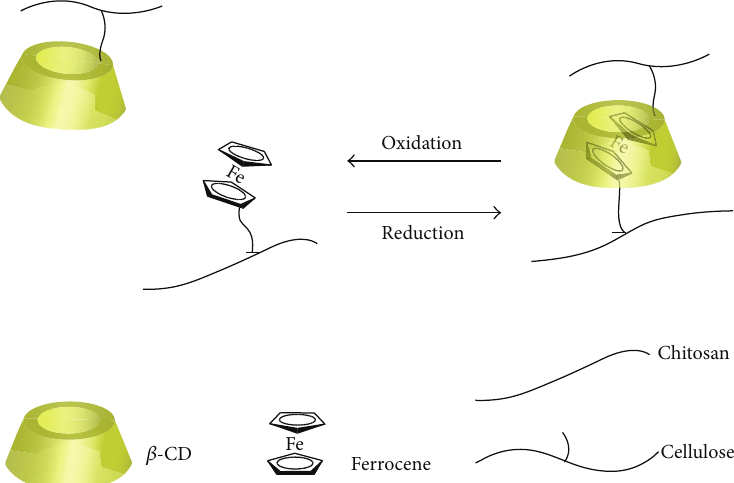
Figure 4: Intermolecular inclusion interaction of cellulose-chitosan hydrogel.